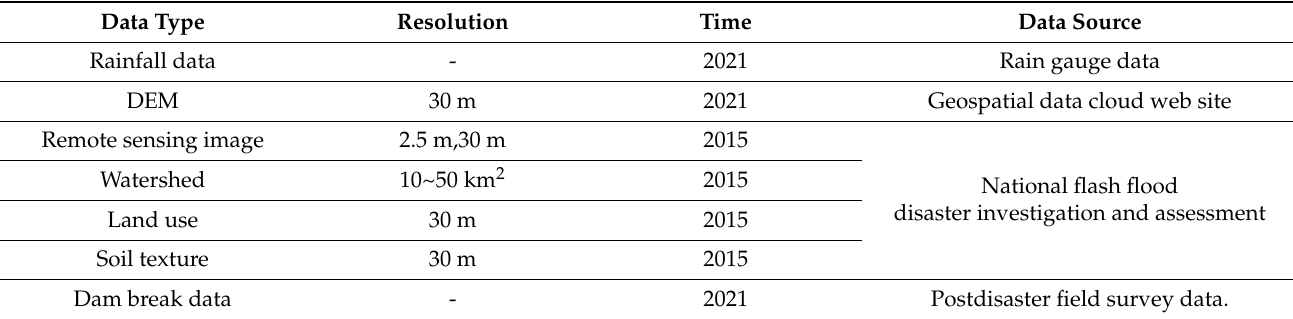
Table 1. Basic data information of study area.